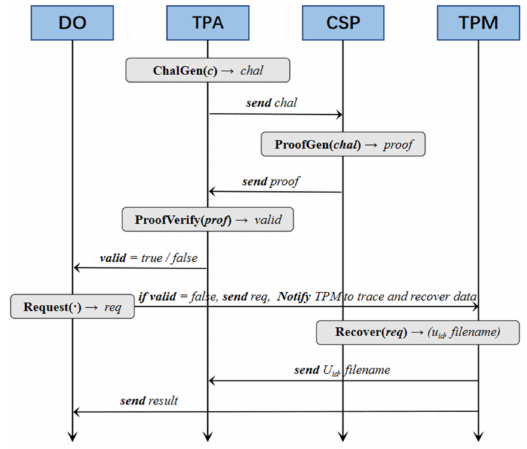
Figure 4. Parameter passing in the verification